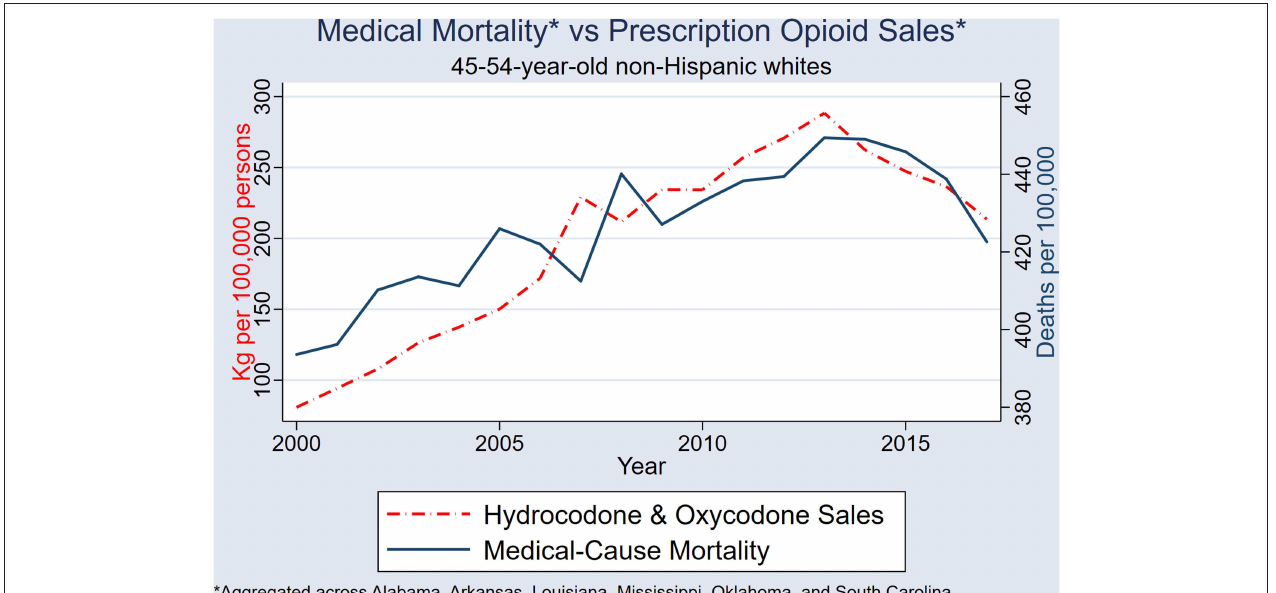
FIGURE 9 | Second differences of state-aggregated, annual hydrocodone sales and female NHW45-54 medical-cause mortality, using a backward adjustment of time series by 1 year.